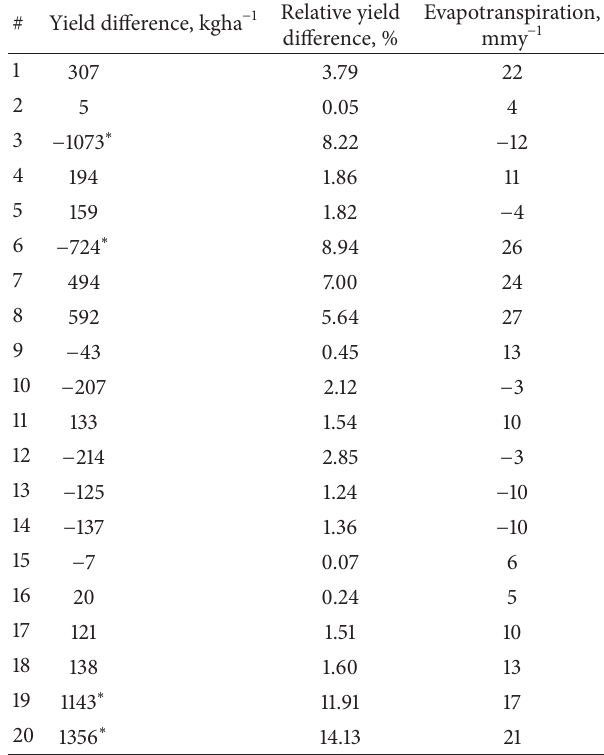
Table 4: Differences in the crop model results obtained by using observed and generated weather data of the central points of the investigated polygons. The parameters for generating artificial weather data were obtained by spatial interpolation using the data of the border points. Asterisk denote significant differences (significance level, 𝛼 = 0.05). Relative yield # Yield difference, kgha − 1 difference, %